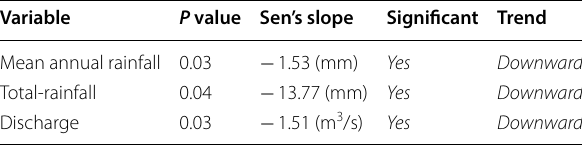
Table 2 Mann–Kendall test and Sen’s slope